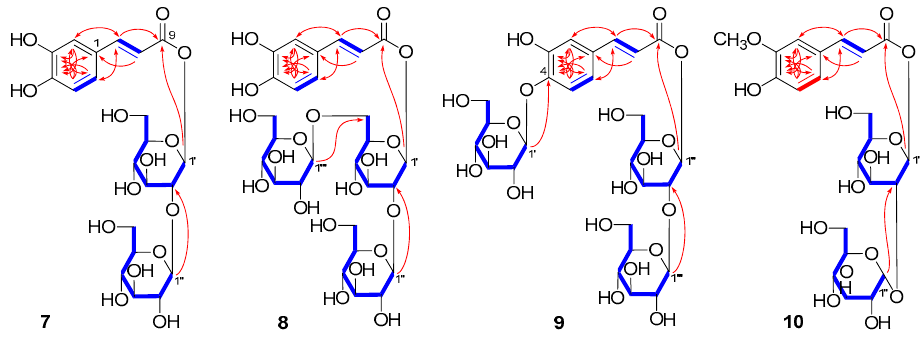
Figure 4. Key 1 H 1 H COSY and HMBC correlations of 7 − 10 . Table 2. 13 C-NMR data for 7 − 10 .